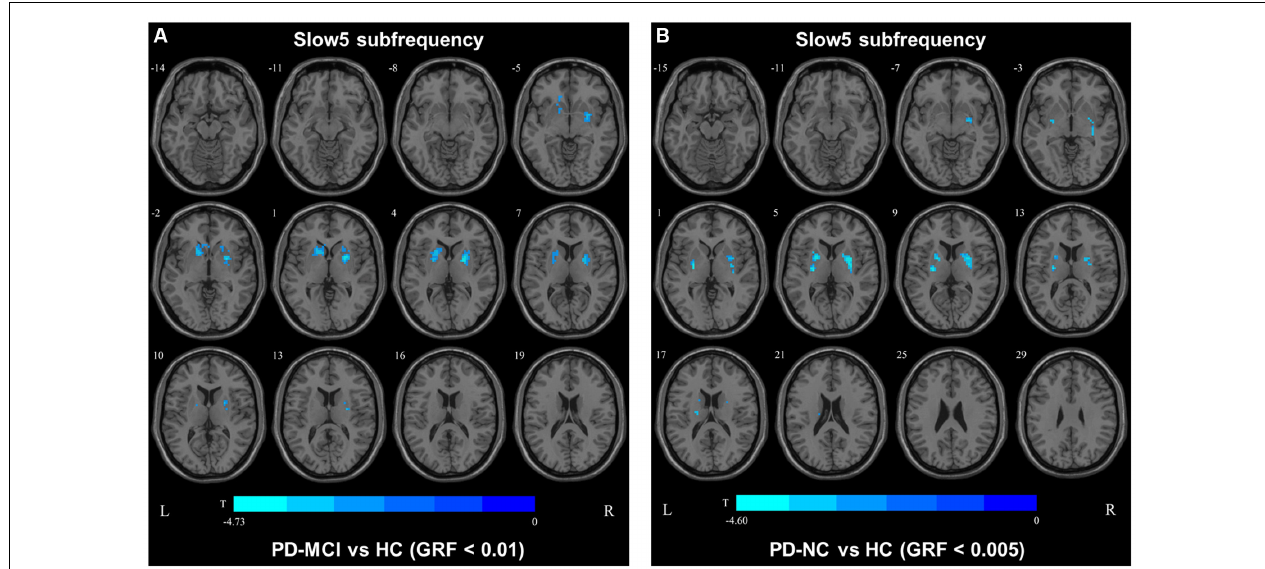
FIGURE 6 | fALFF map differences among the groups in slow5 subfrequency band. The fALFF results were compared by two sample t -tests (PD-MCI vs. HC: GRF corrected, voxel p < 0.01, cluster p < 0.05; PD-MCI vs. HC: GRF corrected, voxel p < 0.005, cluster p < 0.05). The color bar on the bottom indicates the statistical t -value. The cold color indicates a significantly decreased fALFF in the comparison. Additional details regarding these regions with difference are shown in Table 3 . (A) Decreased fALFF in PD-MCI patients between PD-MCI and HC. (B) Decreased fALFF in PD-NC patients between PD-NC and